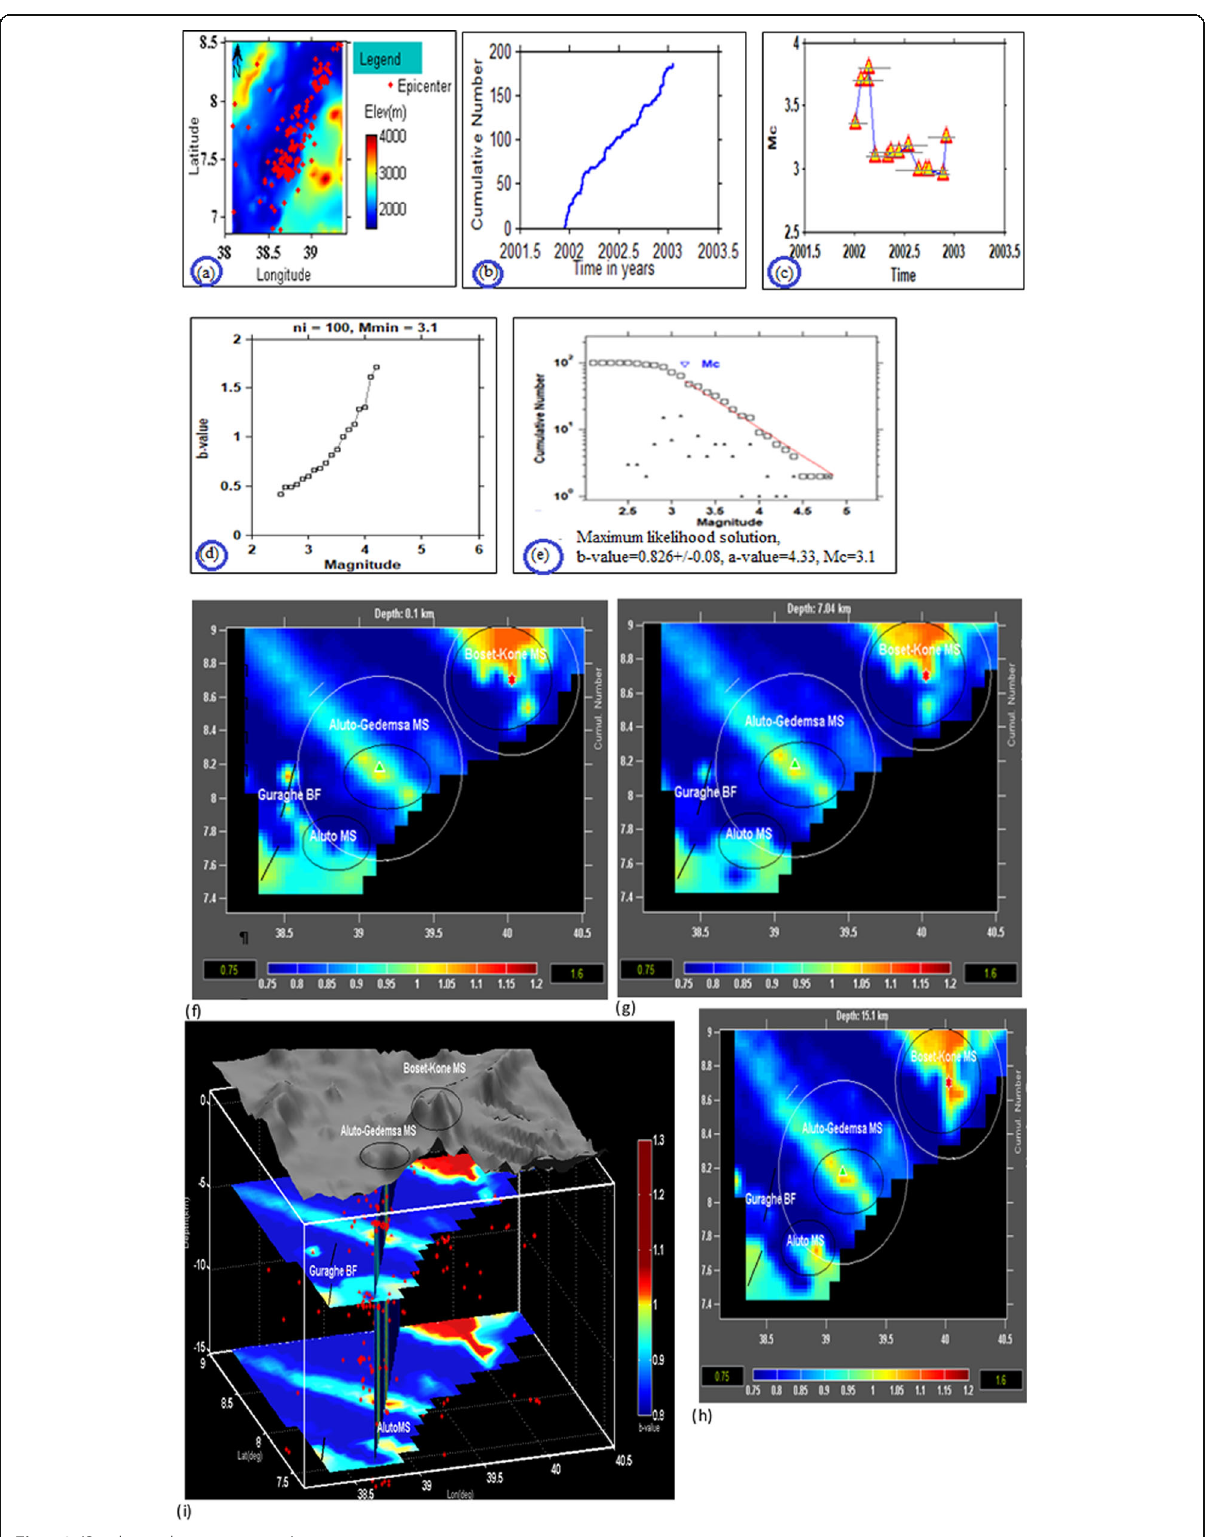
Fig. 12 (See legend on next